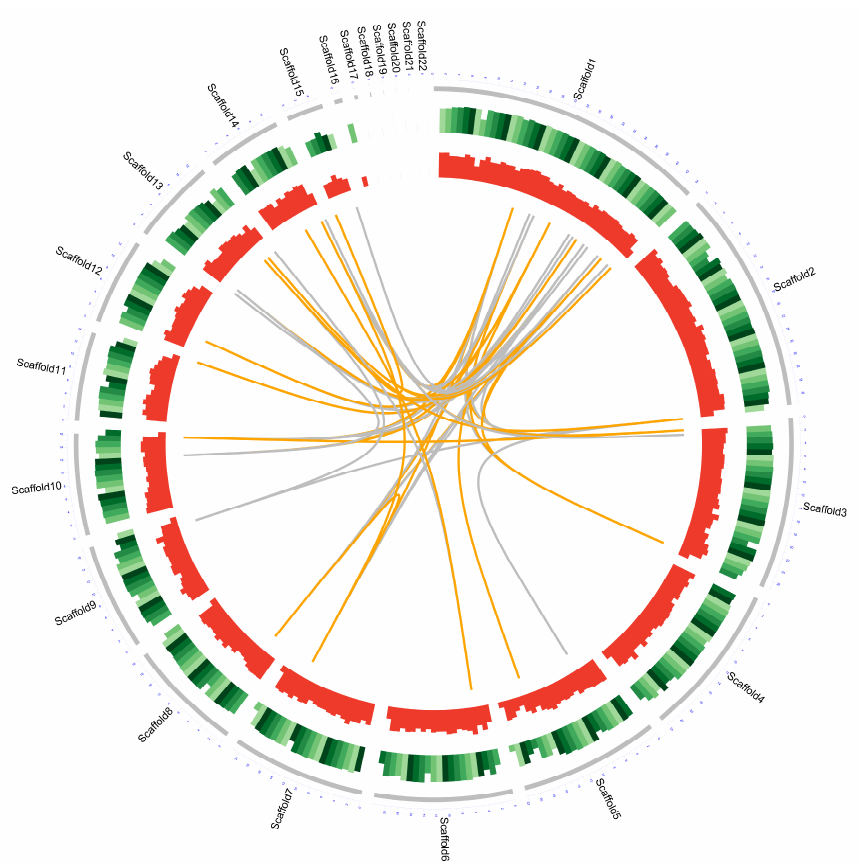
Figure 2. Complete genome map of D. alcacerensis CT-6. From outside to inside: scaffolds, GC content (per 200 kb), gene density (per 200 kb) and genome duplication. Regions sharing more than 95% sequence similarity over 5 kb are connected by grey lines. Those with more than 95% similarity over 10 kb are connected by orange lines.